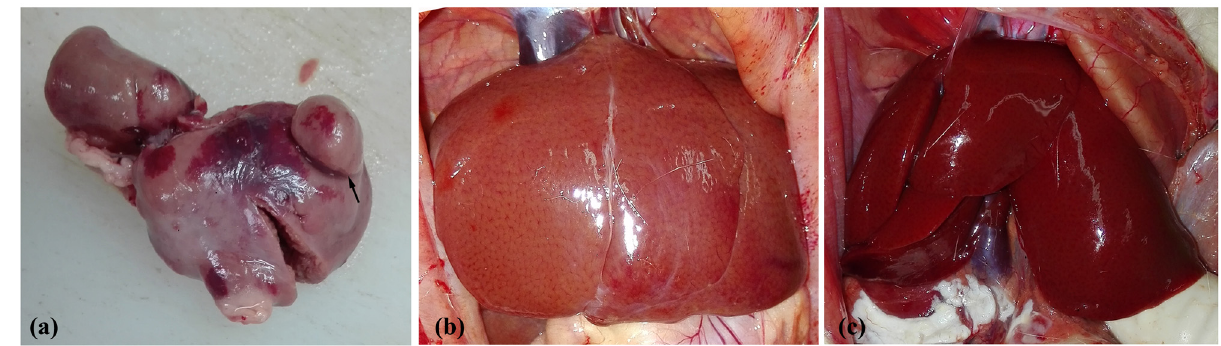
Figure 4: Appearance of the rat liver. ( a ) Liver tissue protruded from the liver surface ( arrow ) at week 8 in the DMF group. ( b ) The liver surface was spotted with a round and blunt edge, and the liver lobe proportion was unbalanced at week 8 in the CCl 4 group. ( c ) The livers in the control group were normal, smooth, and soft